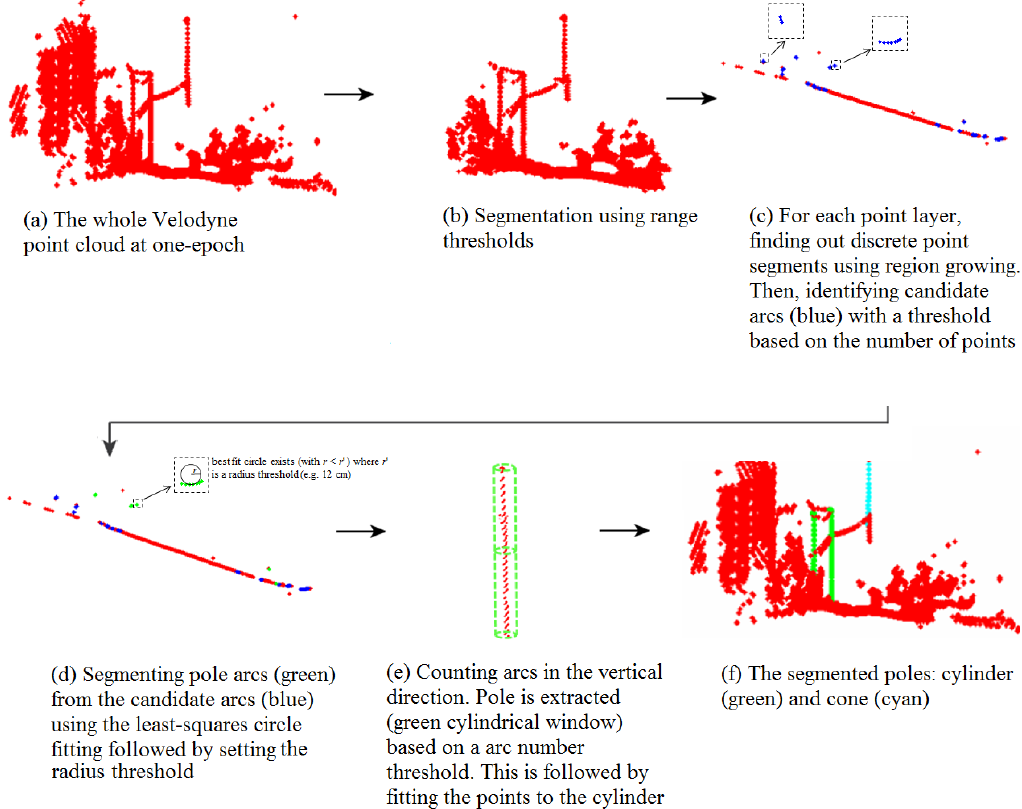
Figure 9. Proposed vertical cylinder segmentation for the kinematic Velodyne point cloud. ( a ) whole point cloud; ( b ) segmentation using range thresholds; ( c ) candidate arc identification; ( d ) pole arc segmentation; ( e ) pole extraction; ( f) segmented